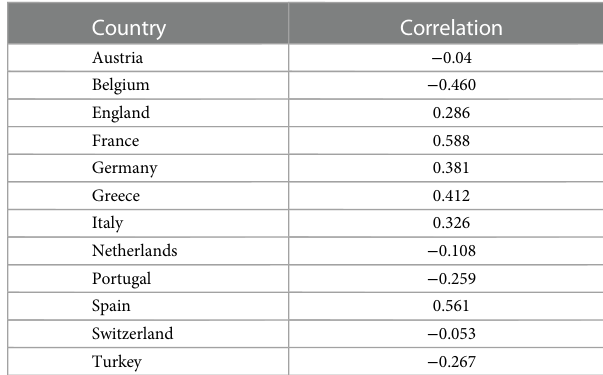
TABLE 3 Correlation gini talent and gini points by country (only fi rst